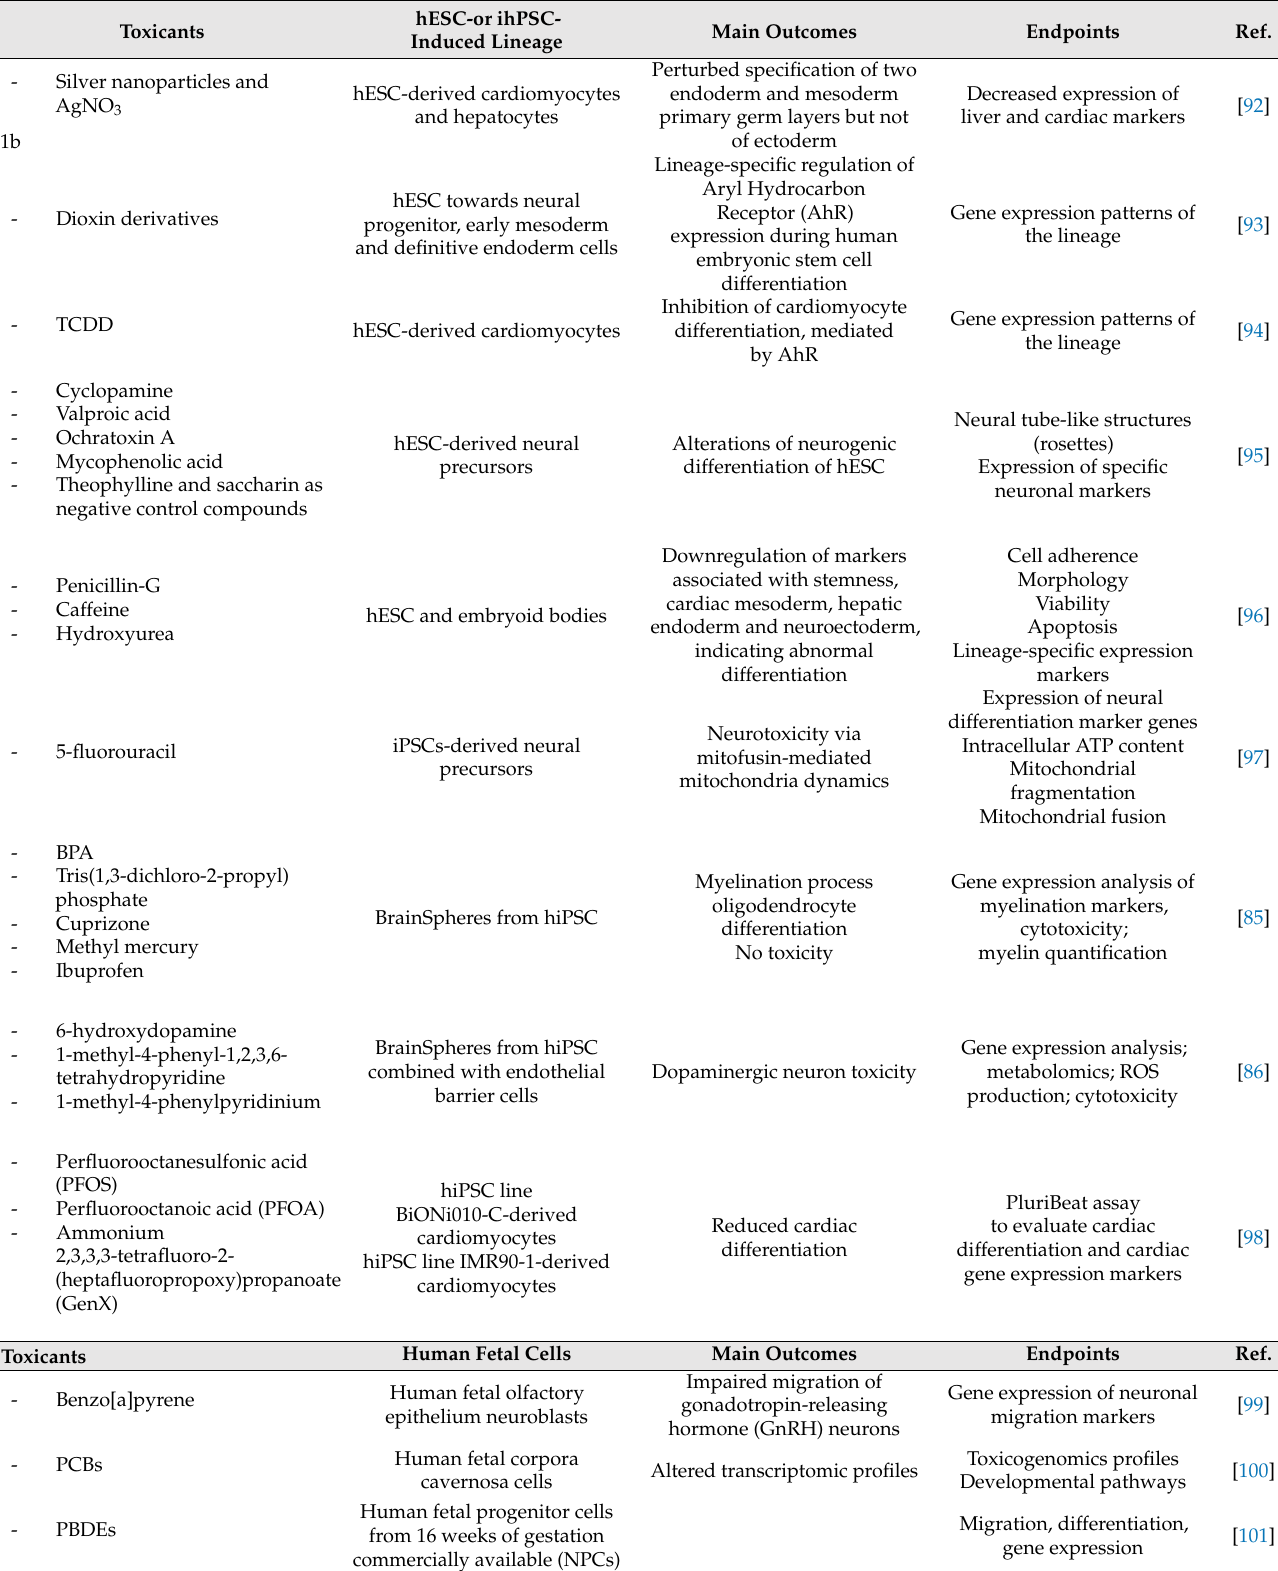
Table 4. Examples of the use of hESCs, hiPSCs and fetal cells for developmental toxicological